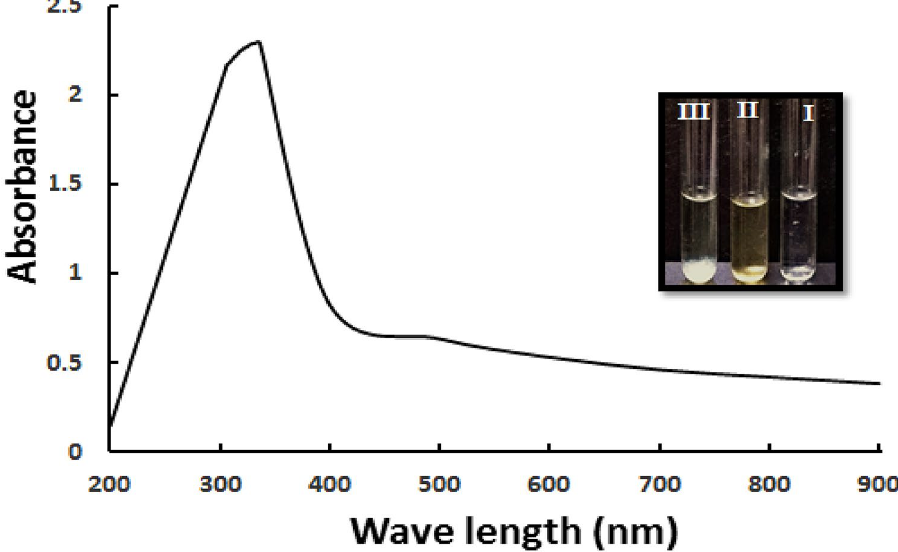
Figure 1. UV–vis absorption spectra of biosynthesised Alk-ZnO NPs, with maximum absorption at 334 nm. Inset shows visual observation of color change (I) Pure precursor (ZnSO 4 .7H 2 O), (II) reducing agent (culture supernatant), (III) white clusters of Alk-ZnO NPs formed after mixing reducing agent and